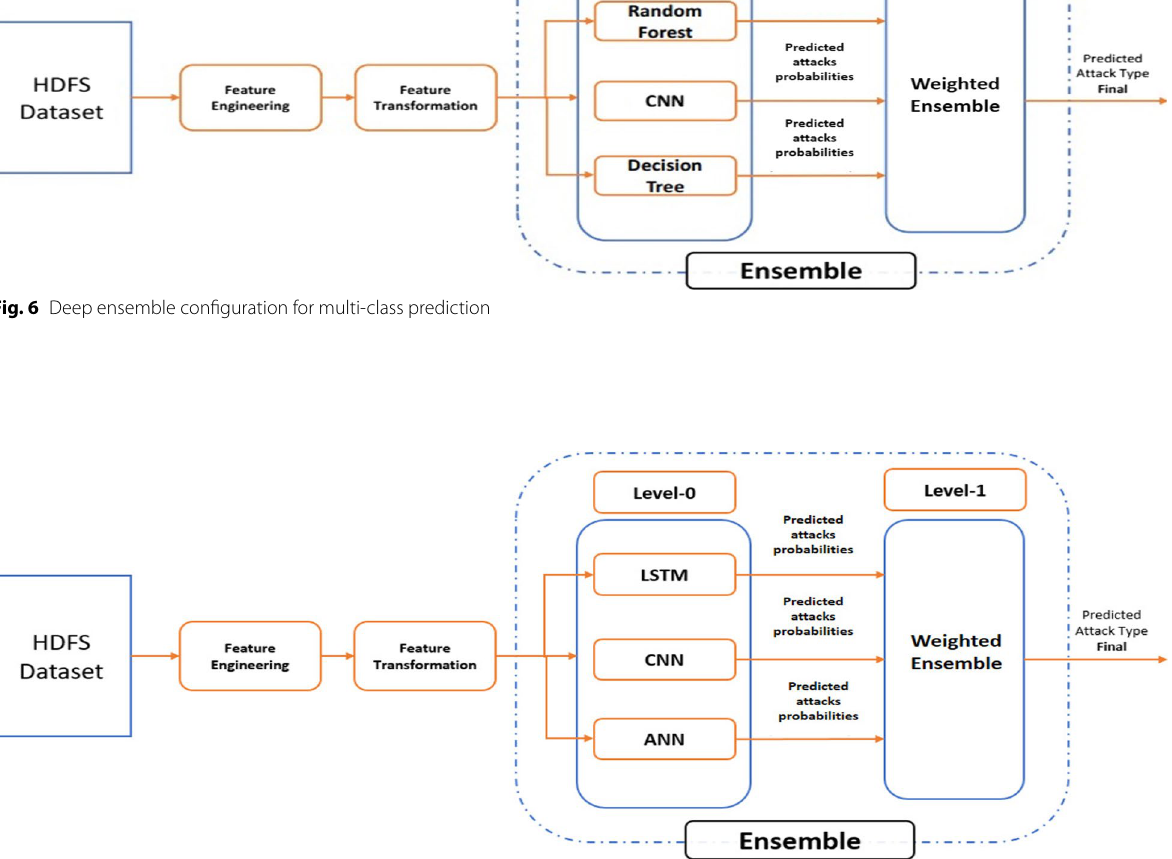
Fig. 7 Hybrid ensemble configuration for multi-class